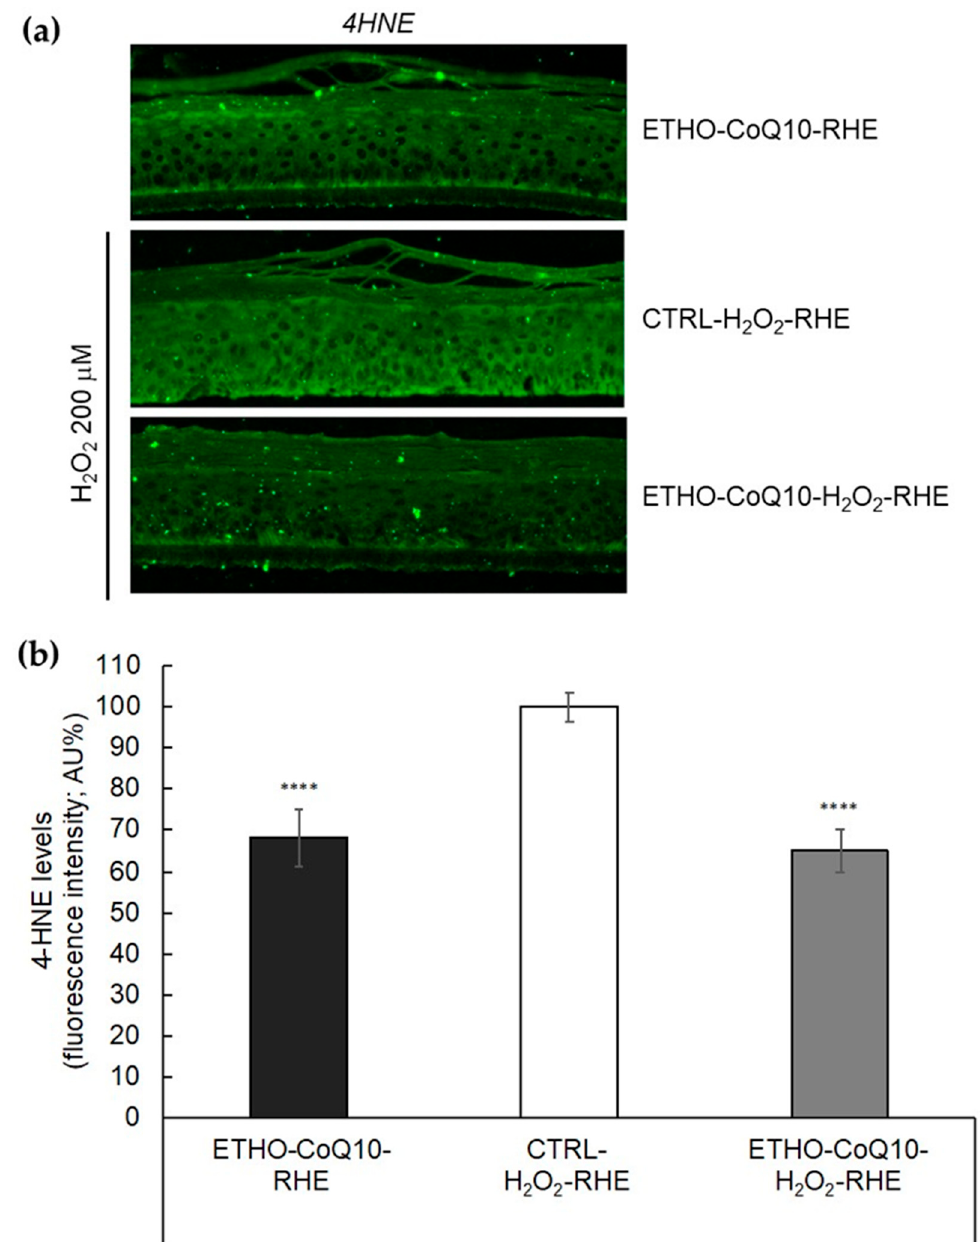
Figure 8. ( a ) Representative immunocytochemical images for 4HNE protein adducts in portions of RHE pretreated with ETHO-CoQ10 (ETHO-CoQ10-H 2 O 2 -RHE) and compared to control RHE treated with ETHO-CoQ10 not exposed to H 2 O 2 (ETHO-CoQ10-RHE), or to RHE exposed to H 2 O 2 200 µ M of H 2 O 2 for 90 min (CTRL- H 2 O 2 -RHE). Images were taken at 40 × . ( b ) Quantification of immunofluorescence staining for 4HNE after H 2 O 2 exposure. Data were normalized with respect to CTRL-H 2 O 2 -RHE and expressed as arbitrary units ± SD. **** p ≤ 0.0001 vs. CTRL.